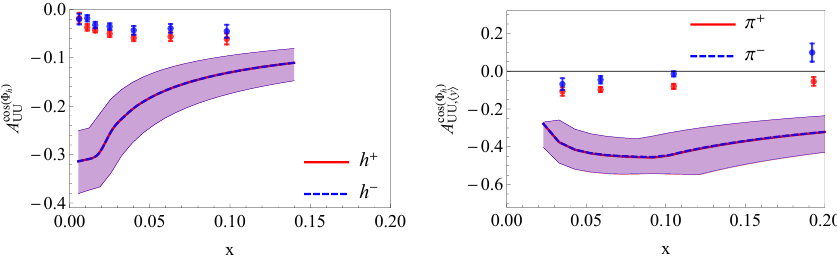
Figure 20. Left panel: asymmetry A cos (cid:30) h proton target [159]. Right panel: the corresponding A cos (cid:30) h